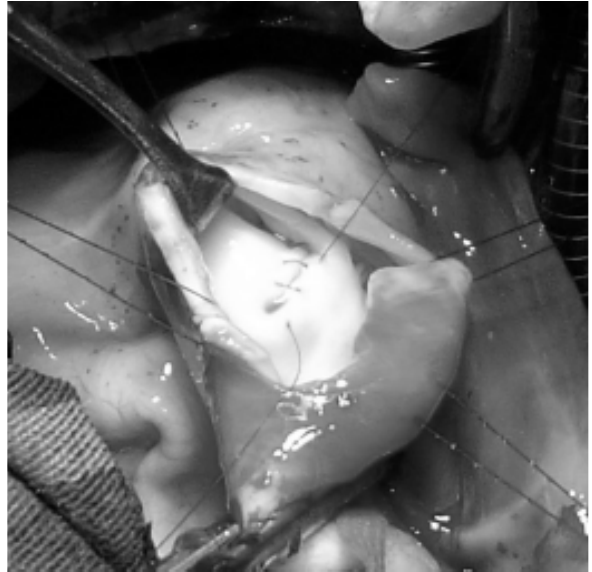
Fig. 2 – Sutura direta para oclusão do túnel ventrículo esquerdo-